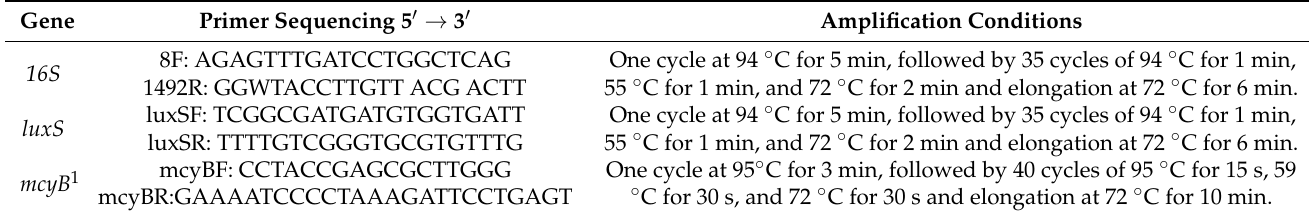
Table 1. Gene identification, primer sequencing, and amplification